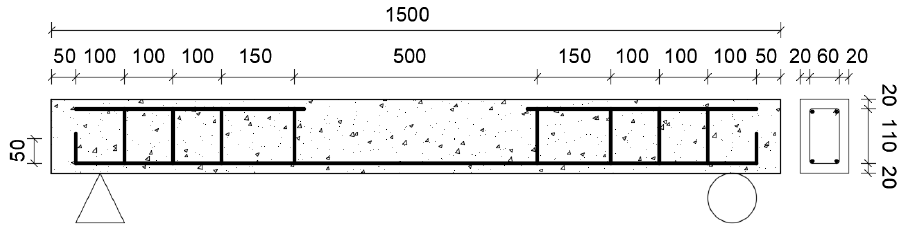
Figure 2. Structure of ceramsite concrete beam (unit: mm).